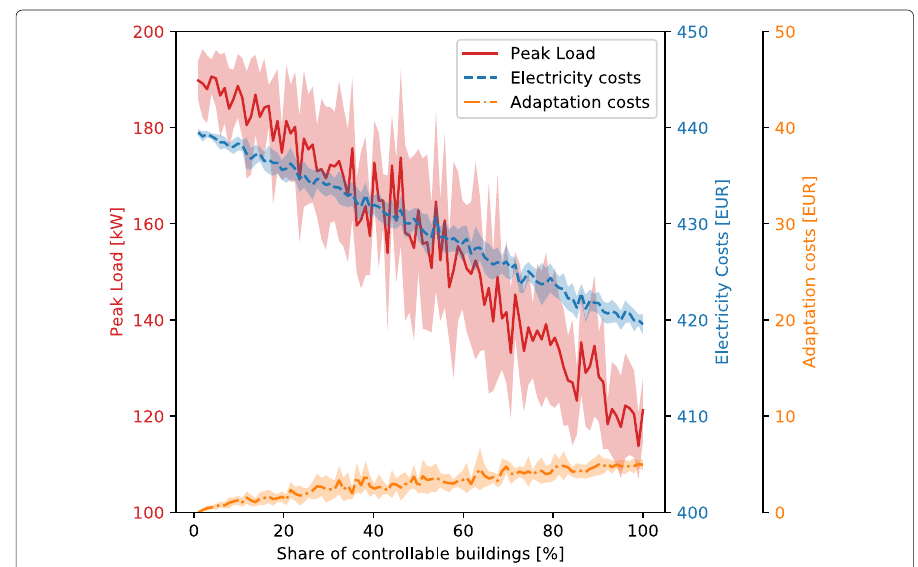
Fig. 4 Results of simulations with a varying number of interconnected buildings regarding the maximum load, the electricity costs and the adaptational costs. For each setting, 10 simulations with different controllable buildings have been executed. The shaded area displays the standard